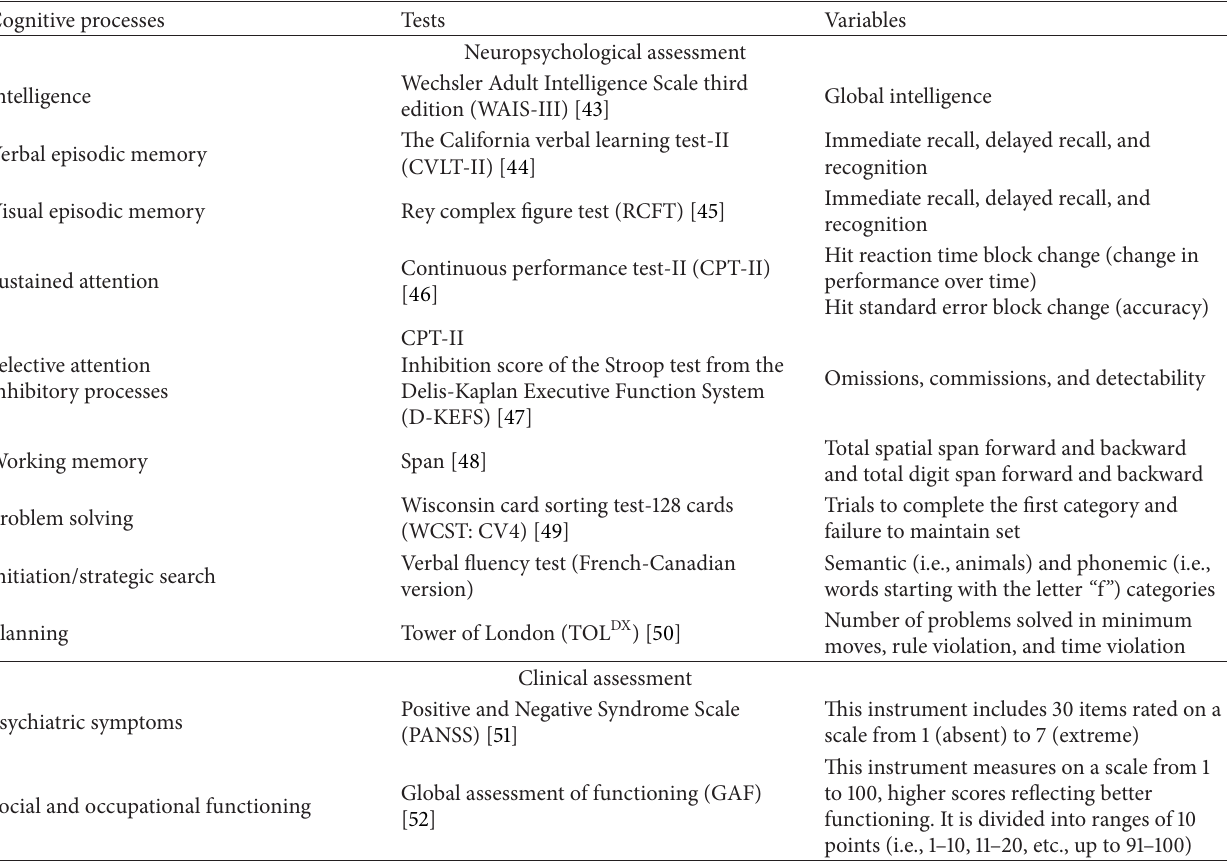
Table 1: Neuropsychological and clinical assessments.